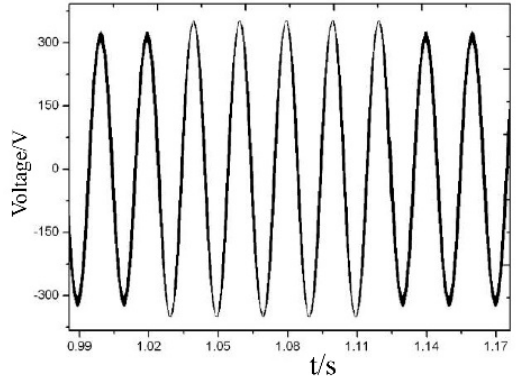
Figure 17. Waveform of voltage swell.